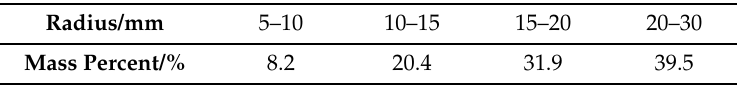
Table 1. The particle-size gradation of the crushed gravel soil.